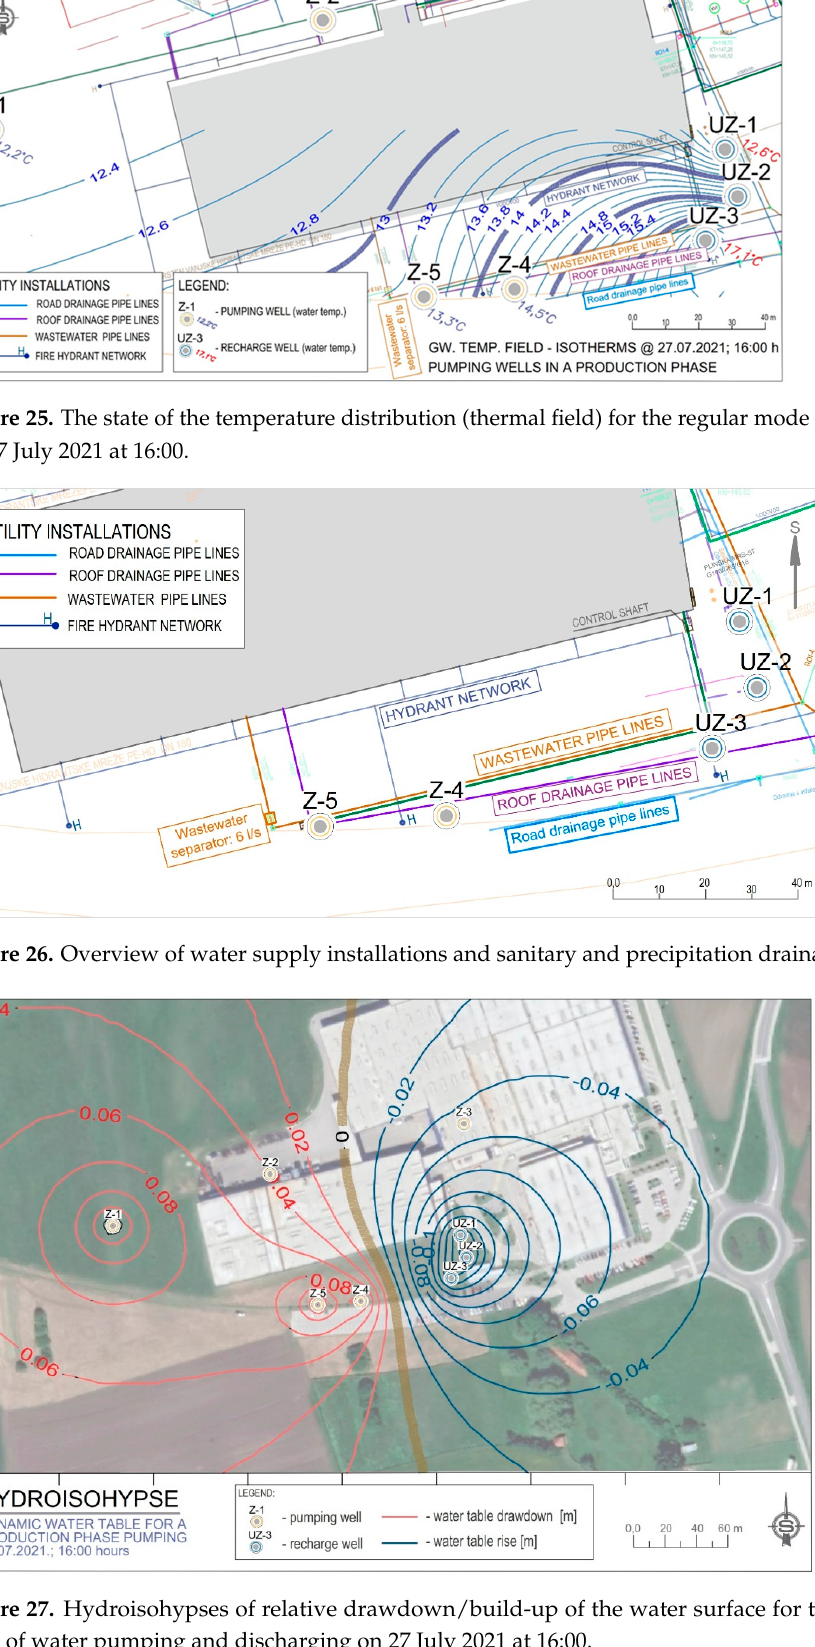
Table 4. Position of wells with discharging/recharging quantities.